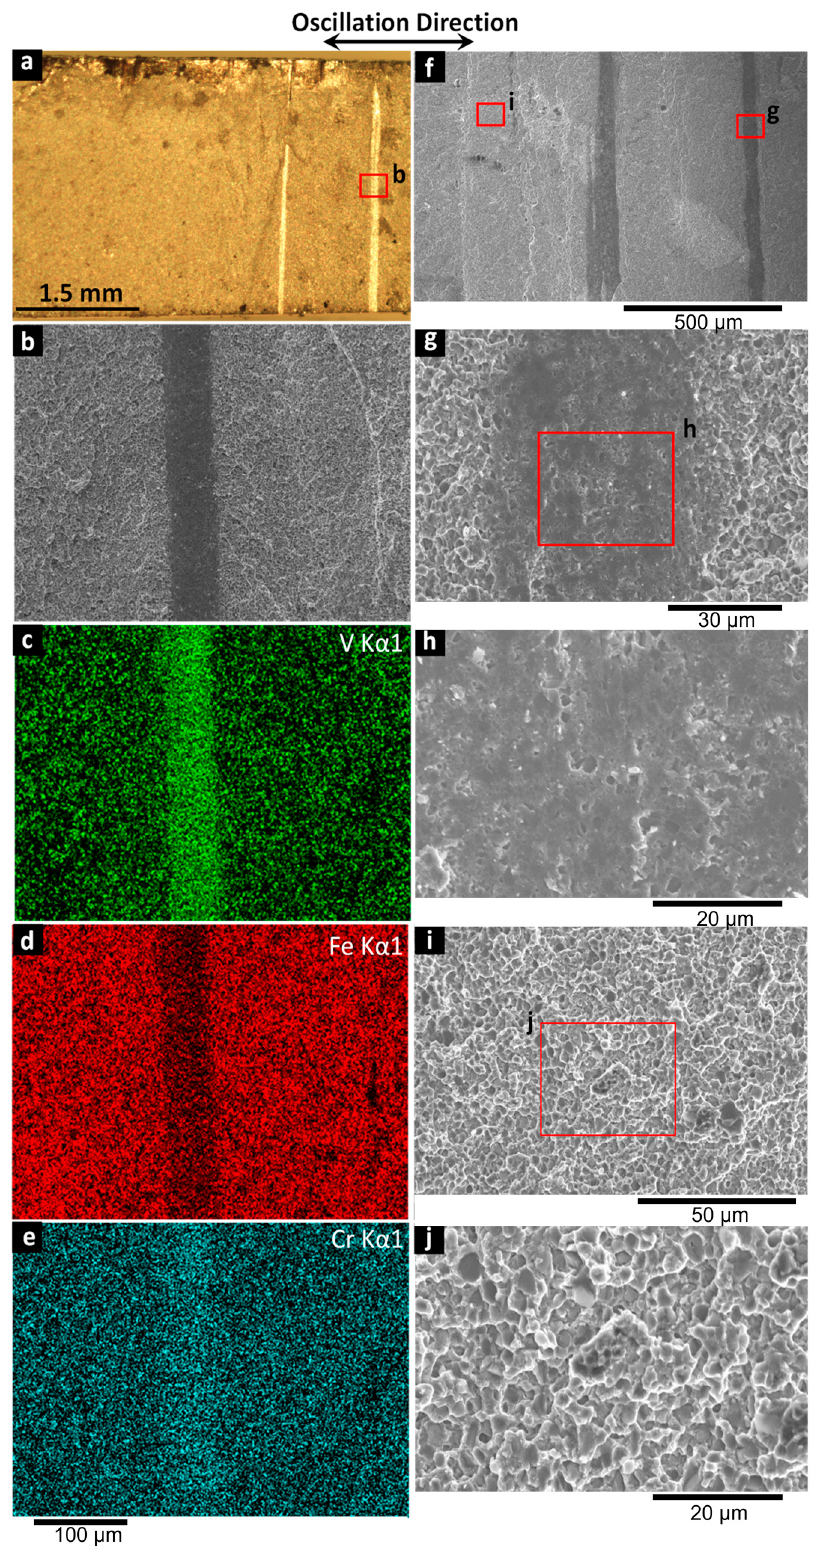
Figure 16. Images of the fracture surface after tensile fracture of HF weld under ( a ) stereomicroscopy, ( b ) SEM, ( c – e ) EDS mapping, and ( f – j ) SEM .